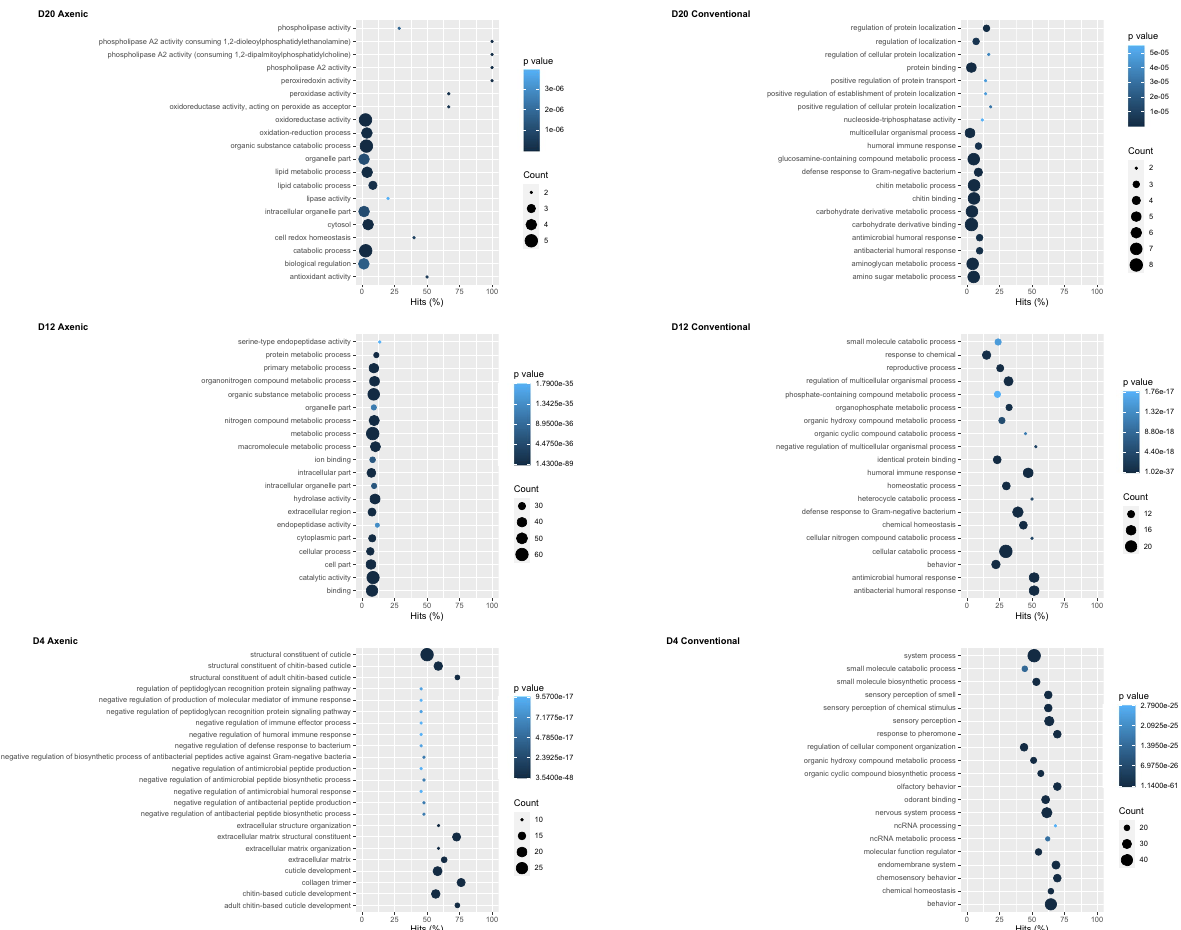
Figure 5. Top 20 terms in the GO enrichment analysis unique to each condition. GO terms that were unmatched (NA) are excluded. The 20 GO terms unique to a condition with the largest DETs ratios are plotted in order of the ratio. The size of the dots is representative of the number of transcripts in the significant up-regulated DETs list (p-adjusted value < 0.01, LFC > 1) associated with the GO term, while the coloration represents the corresponding p-adjusted value of the GO term (FDR < 0.01). The hits axe normalises the number of DETs in the category in relation to the total of genes implicated in this